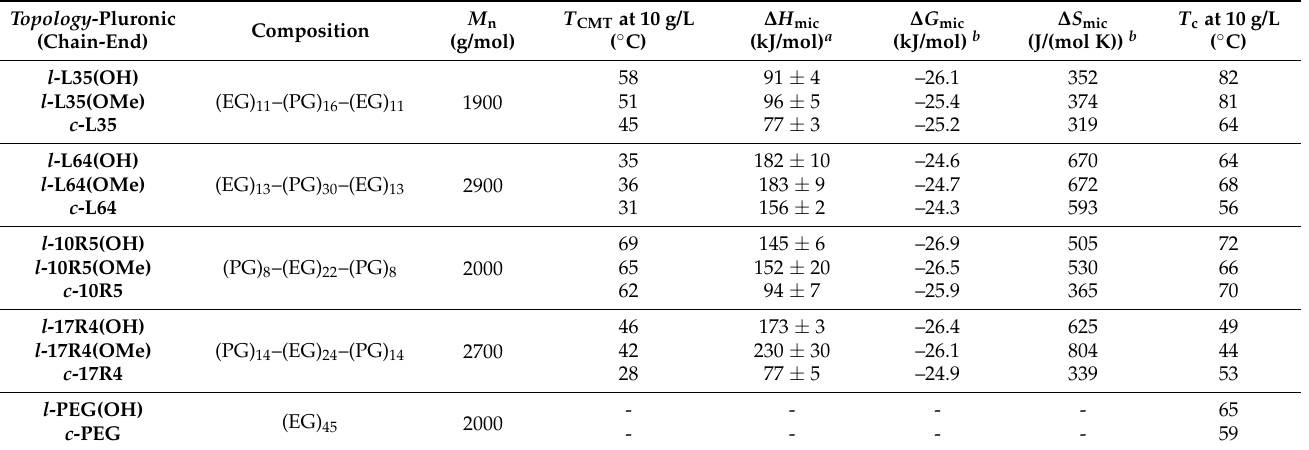
Table 1. Properties of Hydroxy- and Methoxy-Terminated Linear and Cyclized PEG and Pluronic Copolymers and Their Solutions’ Thermodynamic